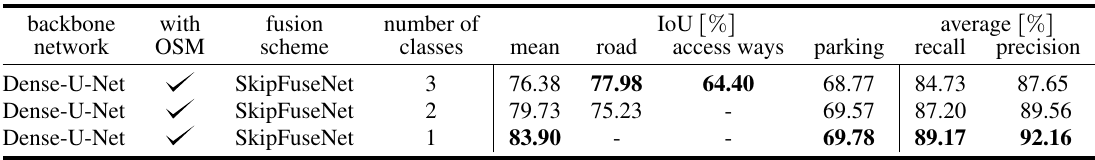
Table 2. Performance of SkipFuse-Dense-U-Net with all 3 classes, roads and access ways merged, or only parking in the ground truth.